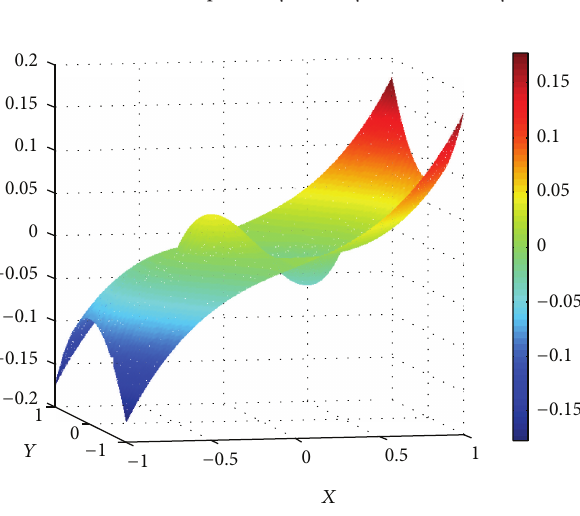
Figure 3: 𝑥 -component, 𝜇 − = 1, 𝜇 + = 100, 𝜆 = 5𝜇 .